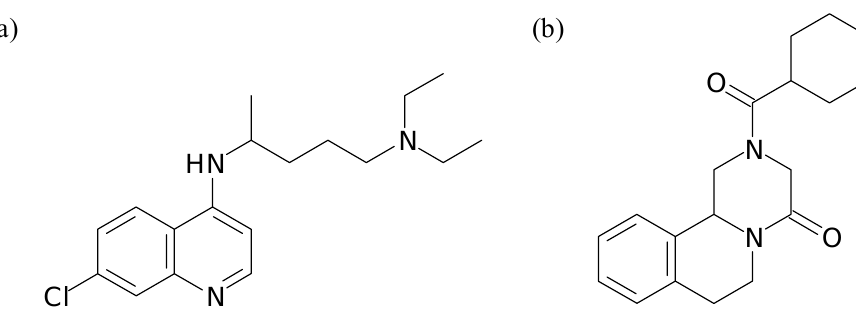
Figure 1. The mainstays of malaria and schistosomiasis chemotherapy: (a) chloroquine and (b) praziquantel,